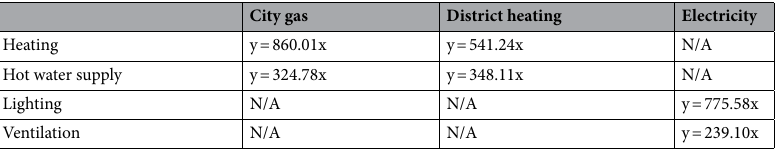
Table 2. GWP assessment standard model equation by energy use and energy source of the apartments. N/A not available, x energy effective area ratio (%), y GWP emissions per gross floor area (kg-CO 2 eq/m 2 ).